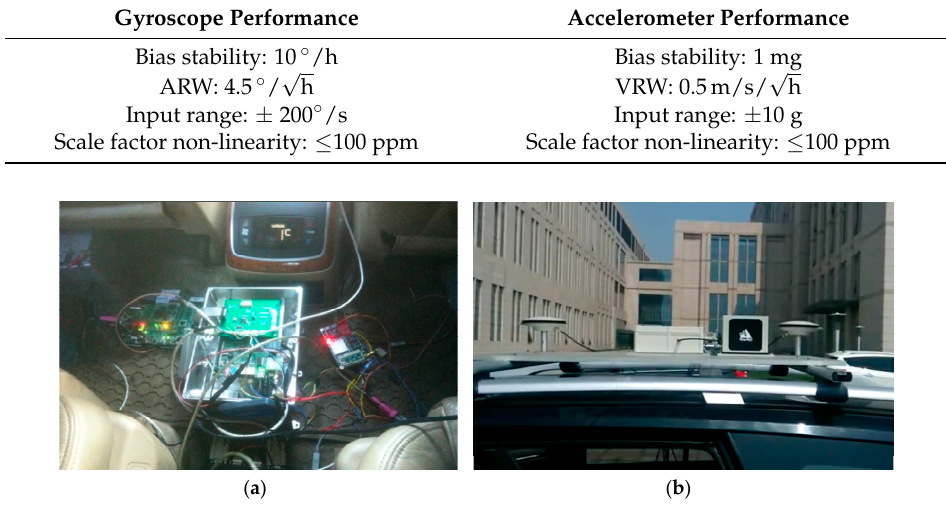
Figure 10. The test vehicle platform and equipment. ( a ) Designed hardware platform; ( b ) GNSS antennas and the NovAtel device. Table 7. Different schemes during the test.